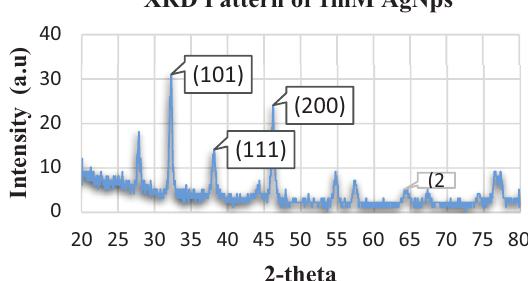
Figure 5. XRD pattern of 1 mM AgNPs of Imperata cylindrica